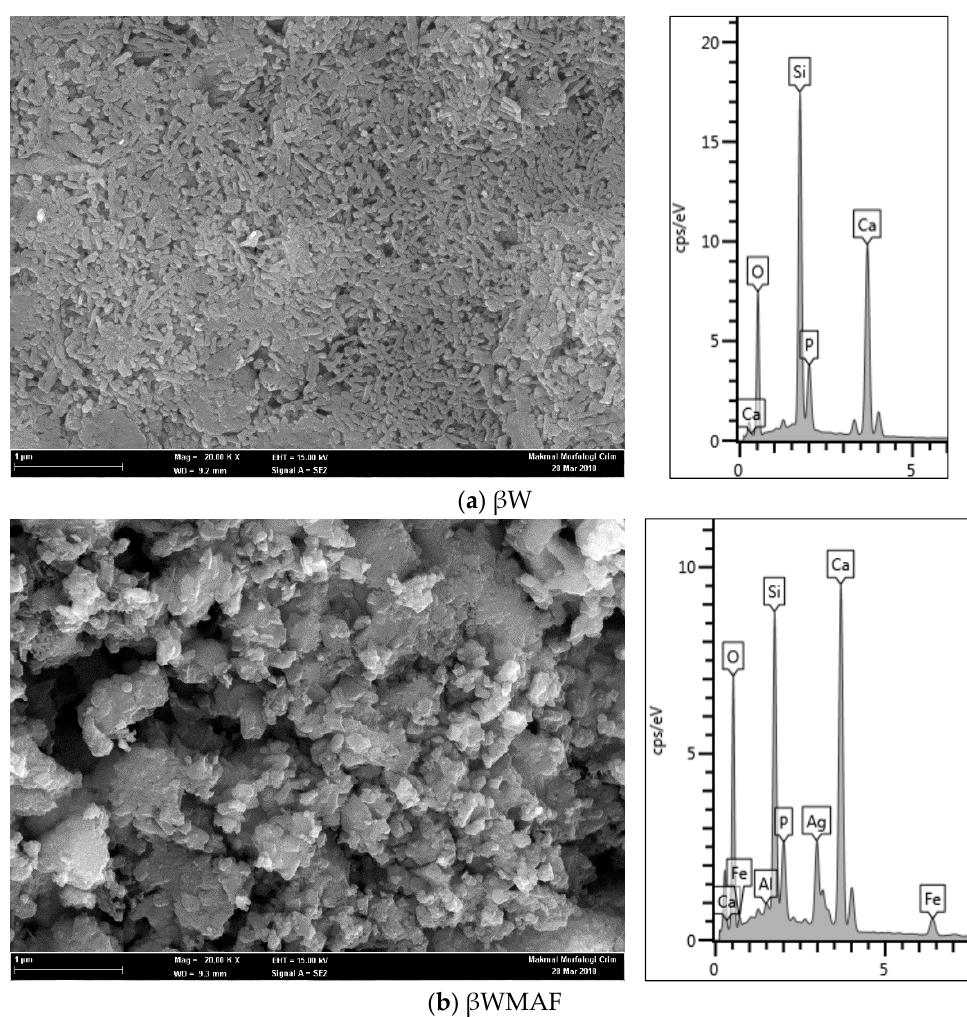
Figure 2. Morphology observation and EDAX spectra of ( a ) β W and ( b ) β WMAF discs.